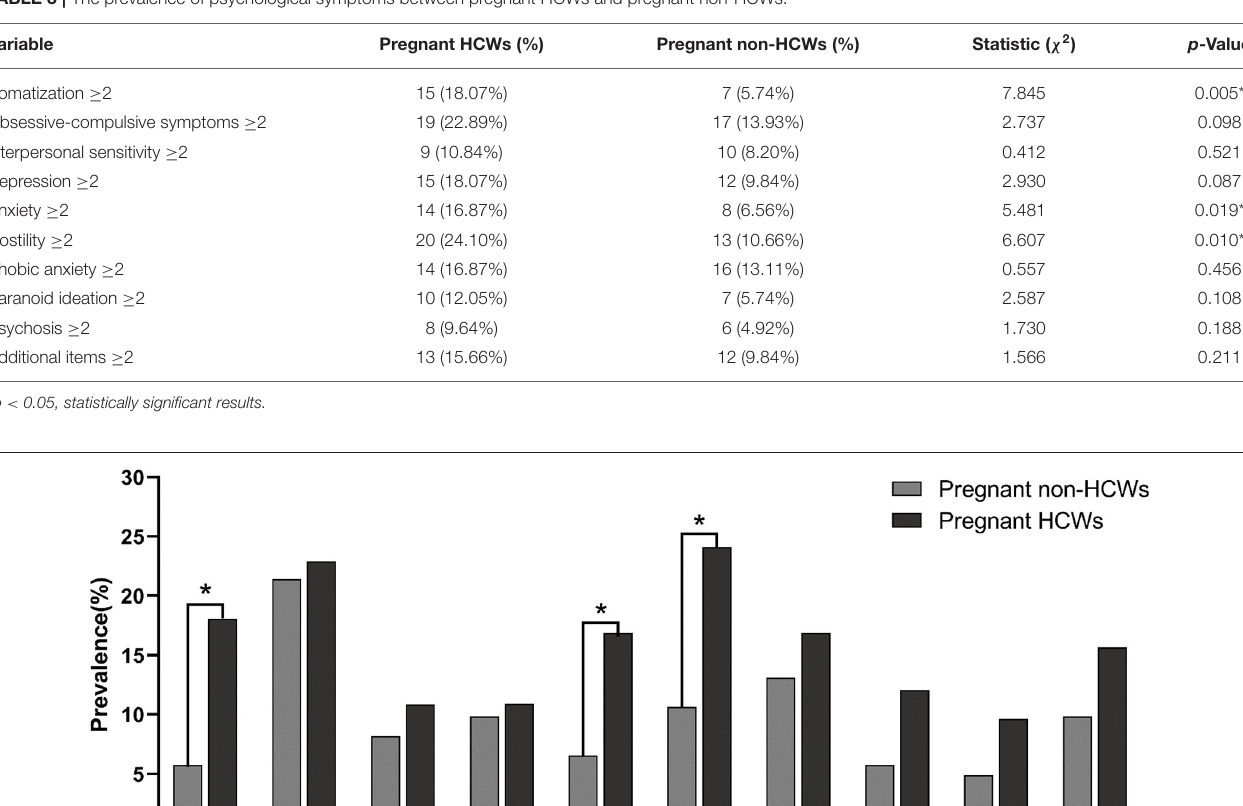
TABLE 3 | The prevalence of psychological symptoms between pregnant HCWs and pregnant non-HCWs.